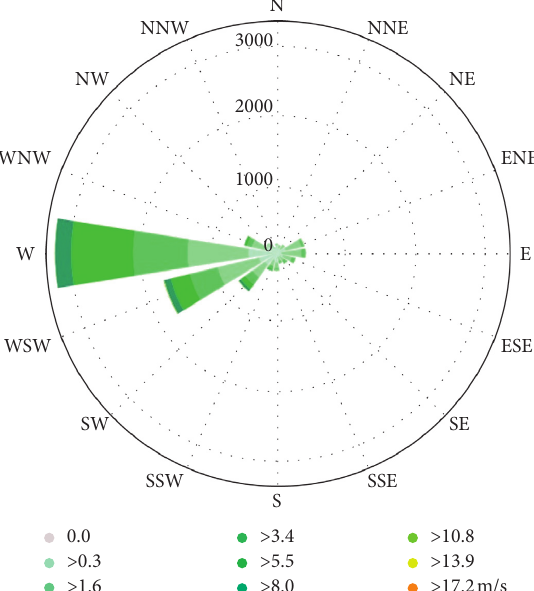
Figure 4: The wind rose for Ramtha showing the annual number of hours the wind blows from each direction [19].